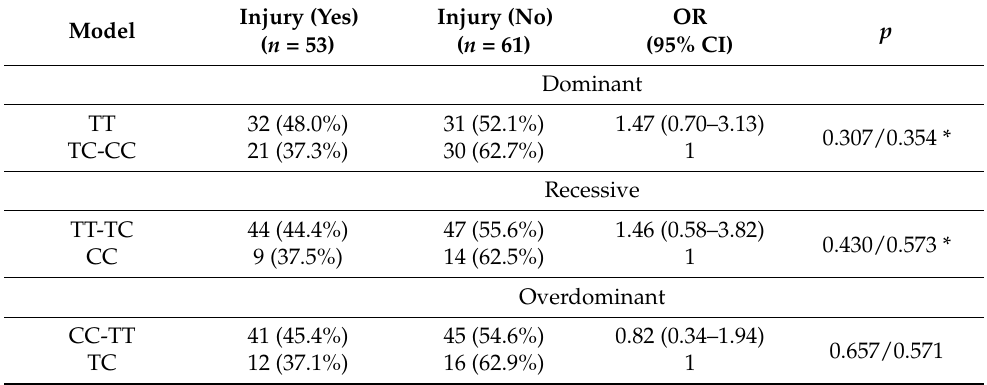
Table 3. Association of the rs12722 COL5A1 polymorphism with injury status.